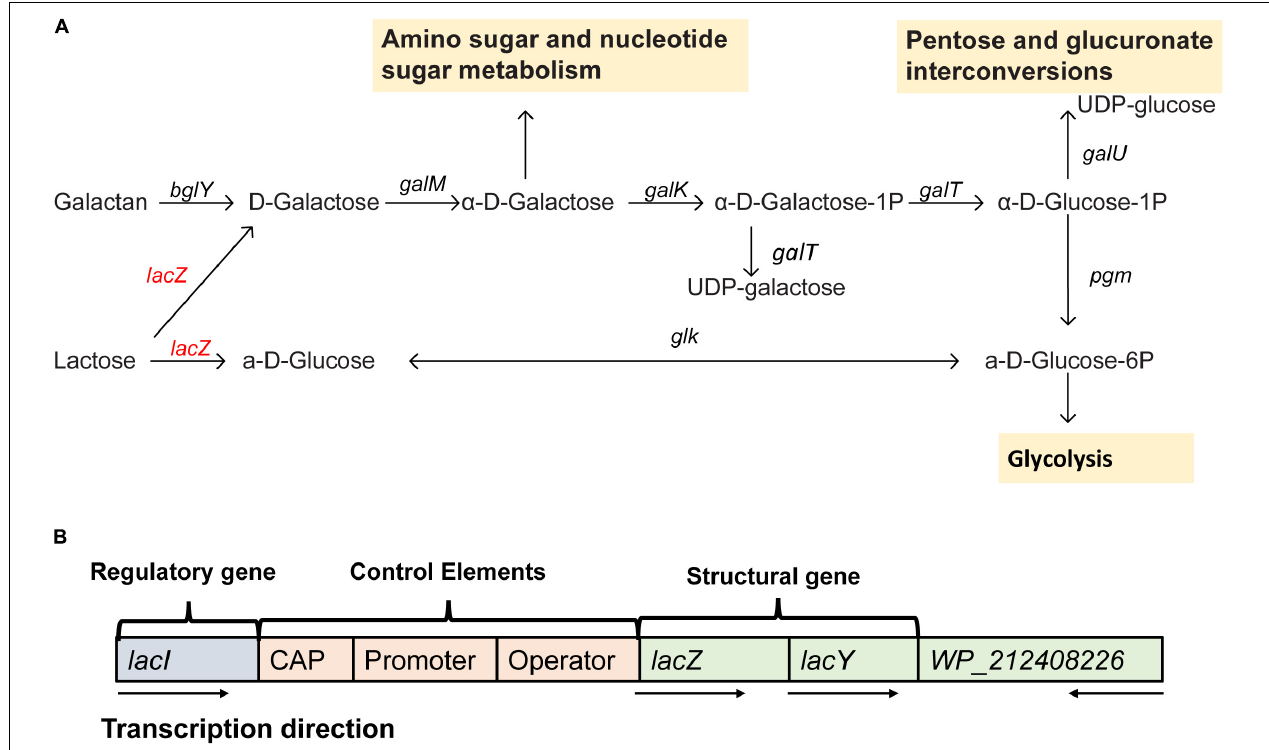
FIGURE 2 | A new plasmid-borne lac operon characterized in Erwinia sp. E602. (A) Lactose-galactose metabolic pathway. Gene names are above the arrow, and the yellow box represents the downstream metabolic pathway. The red color indicates that the gene is located on the plasmid and black means that the gene is located on the chromosome. (B) A structure diagram of the new lac operon and its downstream lacI -like gene encoding the WP_212408226 protein. The arrows indicate the transcription directions of the genes.